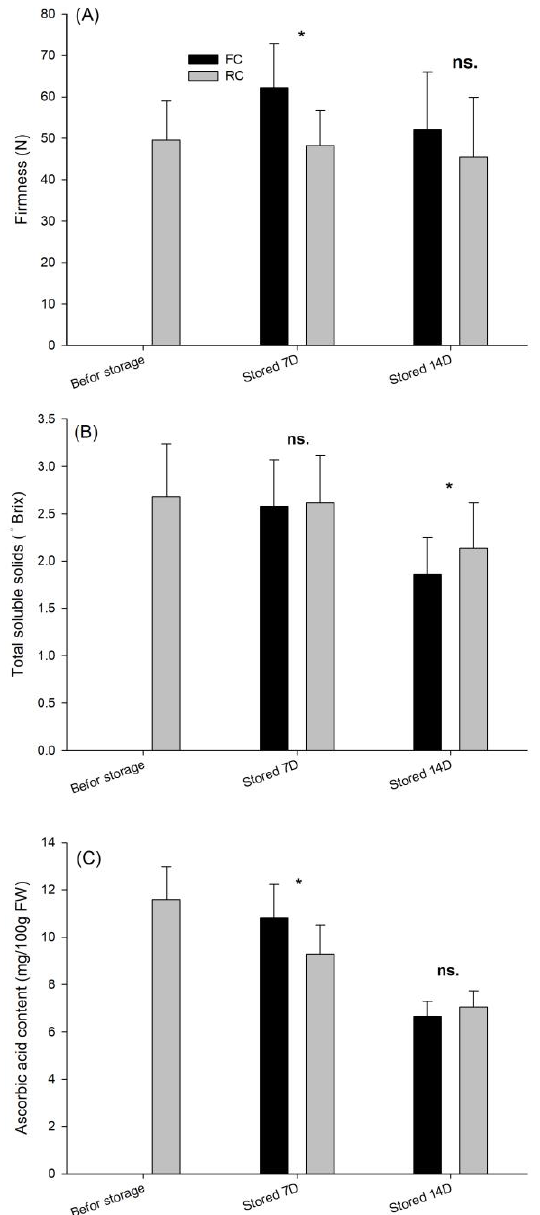
Figure 3. Effects of FC and RC on the ( a ) texture, ( b ) total soluble solids, and ( c ) ascorbic acid content of winged bean pods during storage. * Significant differences between the two treatments according to the least significant difference test ( p < 0.05). ns. — non-significant difference between the two groups. Data are expressed as mean ± SD of three replicates ( n = 3).